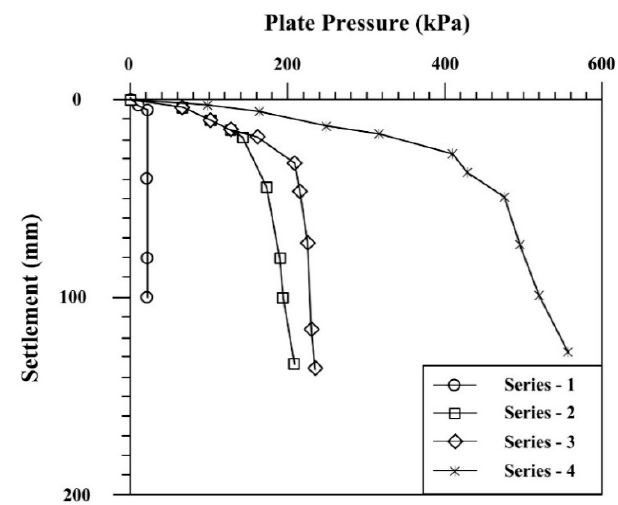
Figure 5. Performance with a 150-mm-thick gravel layer (modified from Rajagopal and Ramakrishna [36]).